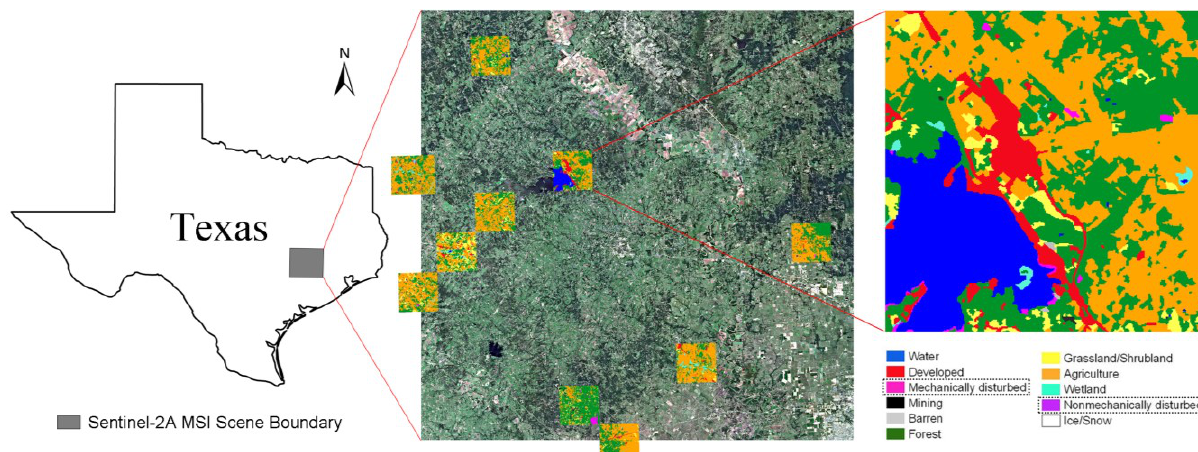
Figure. 2. Study area and data. The middle background is the true color composited Sentinel-2 MSI image (Bands 4, 3, and 2). A total of 10 Land Cover Trends (LCT) sample blocks (three parts) are located within the image. The two ignored disturbance classes (mechanically disturbed and non-mechanically disturbed) are marked by dotted box.